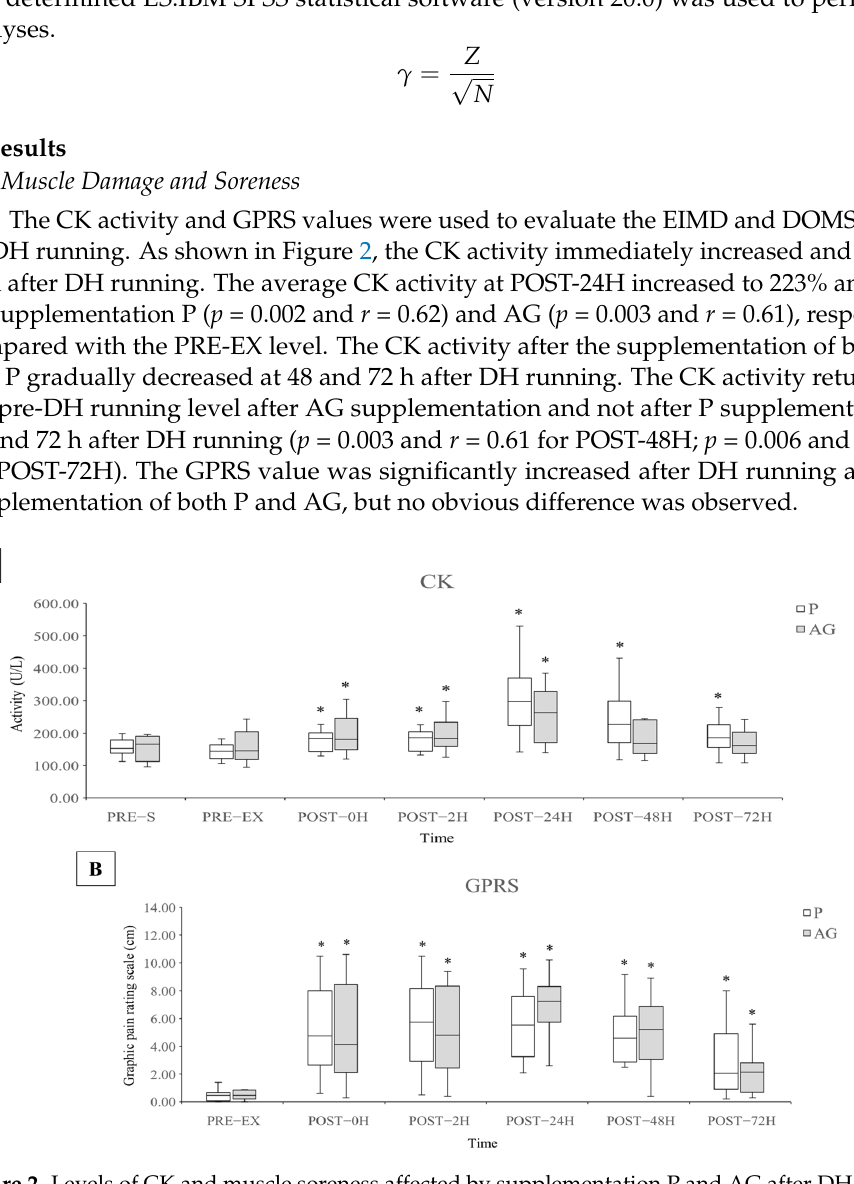
Figure 2. Levels of CK and muscle soreness affected by supplementation P and AG after DH running. Q1, median, Q3, minimum, and maximum values of CK (A) and GPRS (B) are presented in boxplots ( N = 12 for CK; N = 10 for GPRS). * p < 0.05 vs. PRE-EX. AG: American ginseng; CK: creatine kinase; GPRS: graphic pain rating scale; P: placebo.